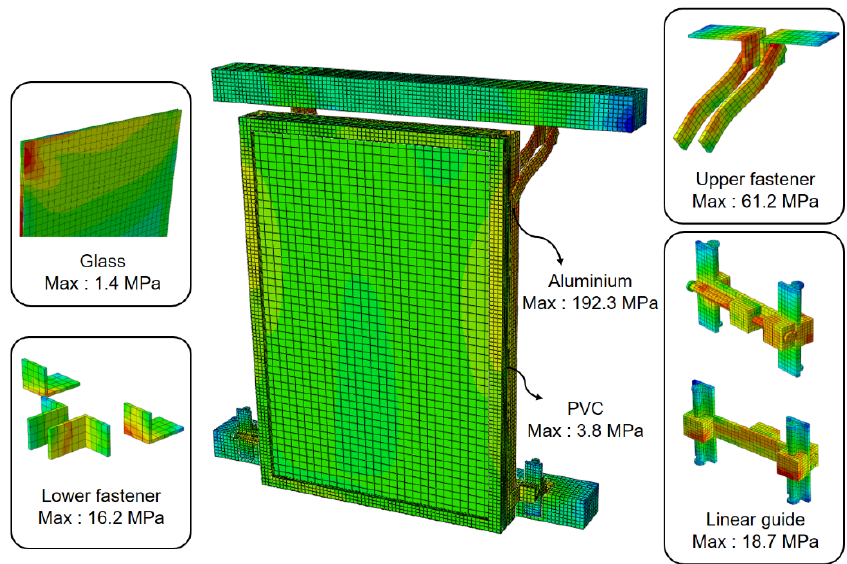
Figure 32. Stress distribution applied to each member: linear guide length 100 mm.